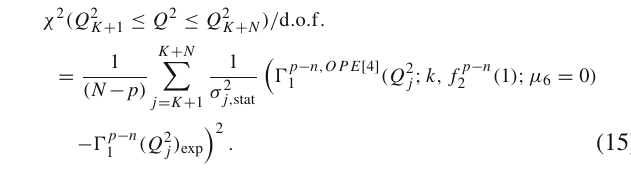
Fig. 1 Fits of the OPE expression (10) truncated at D = 2 term, i.e., μ 6 = 0, to the experimental data for (cid:2) p different QCD variants, where in the fits: a Q 2 ≥ 0 . 66 GeV 2 ; b